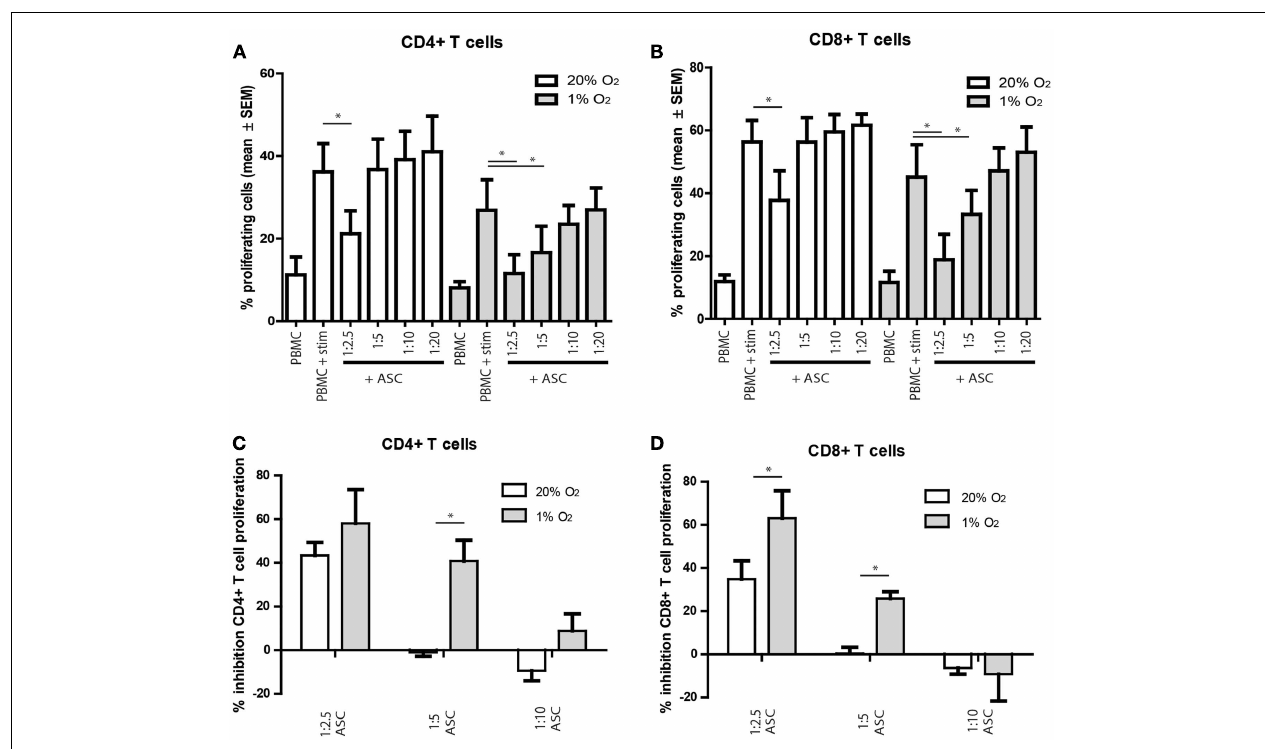
shown. (C,D) percentage inhibition of proliferation shown, compared to the condition without ASC. Mean with SEM of three experiments with different ASC cultures shown, * p -value <